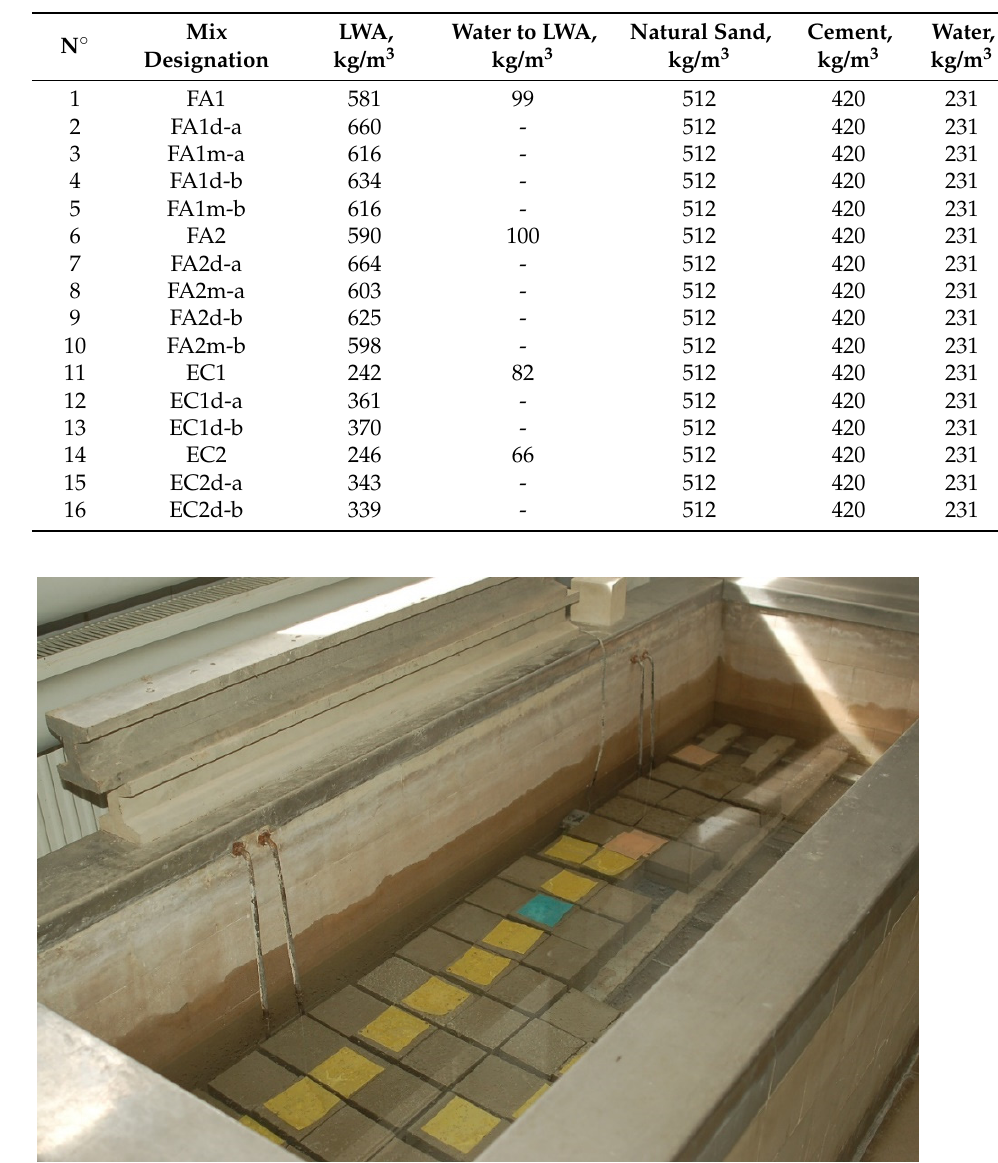
Figure 3. Curing cube specimens in water until